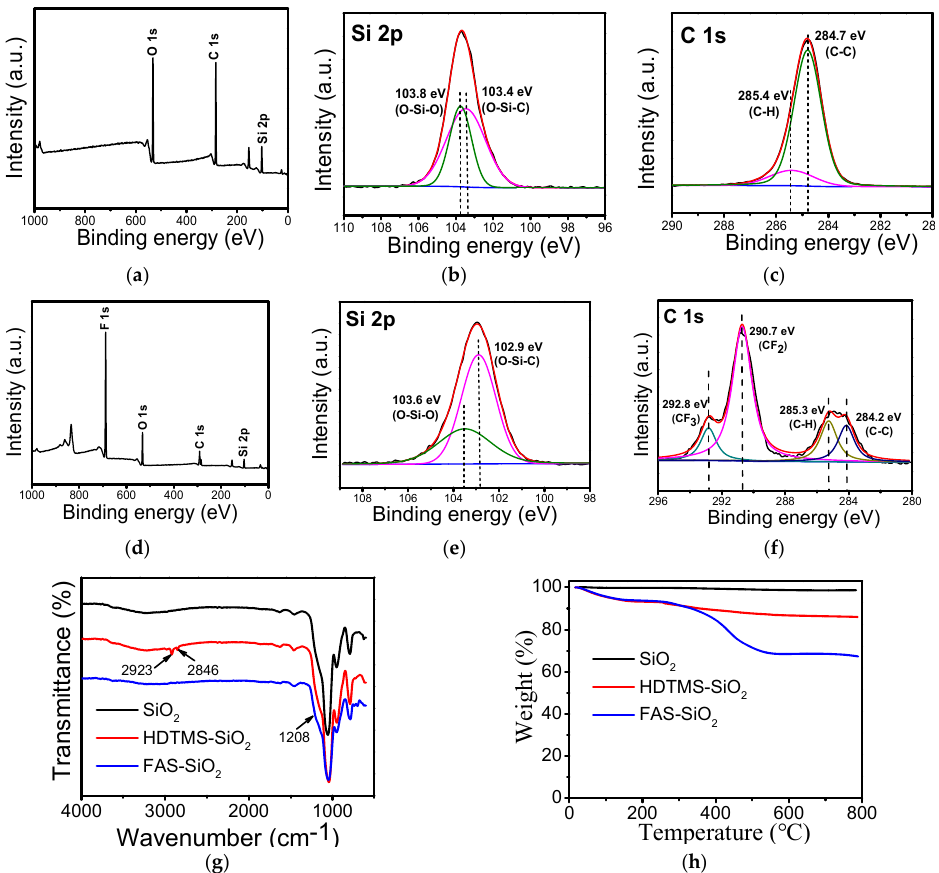
Figure 1. ( a ) Low-resolution, ( b ) Si 2p high-resolution, and ( c ) C 1s high-resolution XPS spectra of HDTMS-SiO 2 nanospheres; ( d ) Low-resolution, ( e ) Si 2p high-resolution, and ( f ) C 1s high-resolution XPS spectra of FAS-SiO 2 nanospheres; ( g ) FT-IR spectra of SiO 2 and modified SiO 2 nanospheres; ( h ) TGA curves of SiO 2 and modified SiO 2